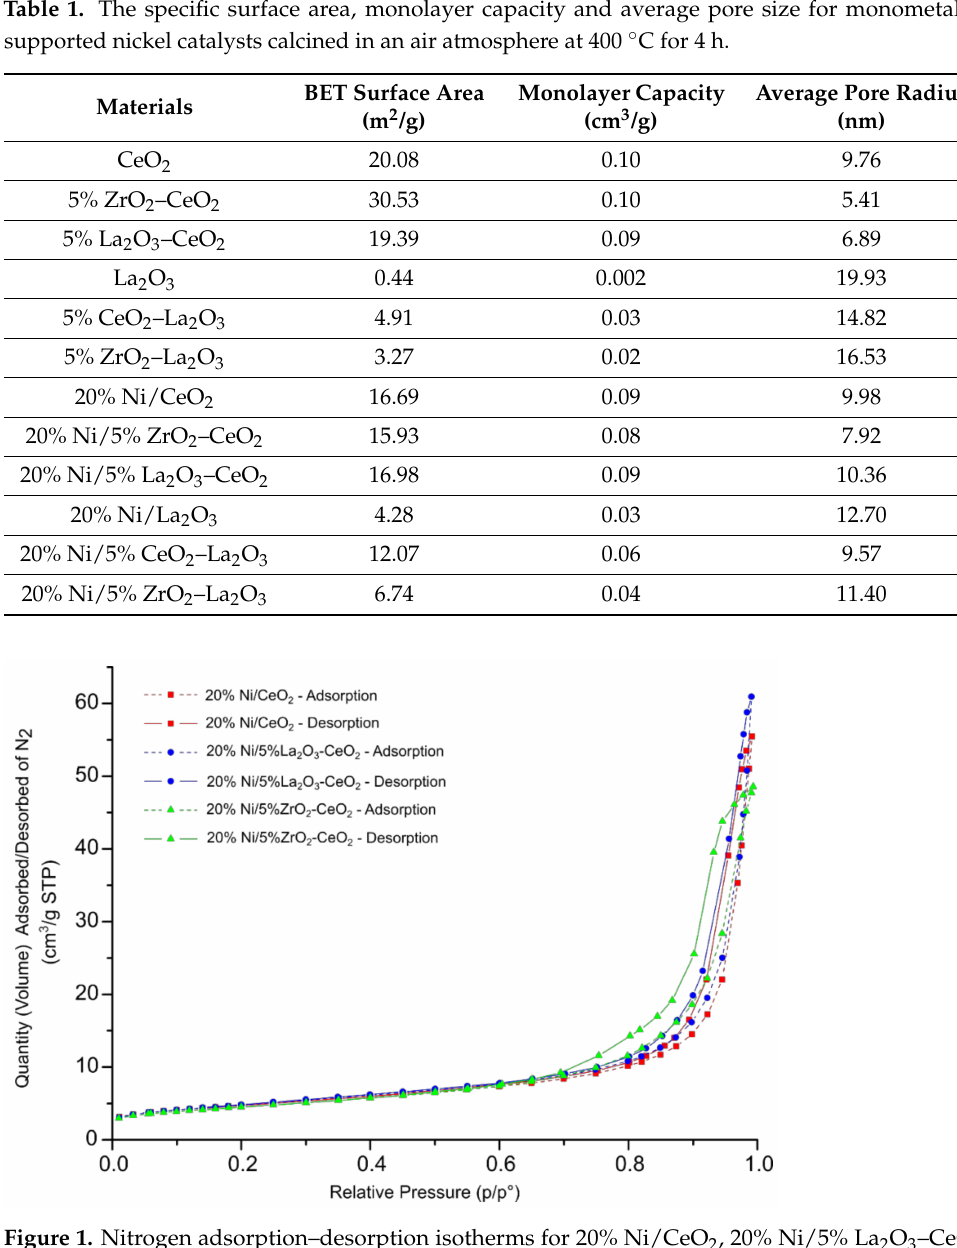
Figure 1. Nitrogen adsorption–desorption isotherms for 20% Ni/CeO 2 , 20% Ni/5% La 2 O 3 –CeO 2 and 20% Ni/5% ZrO 2 –CeO 2 catalysts calcined in an air atmosphere at 400 ◦ C for 4